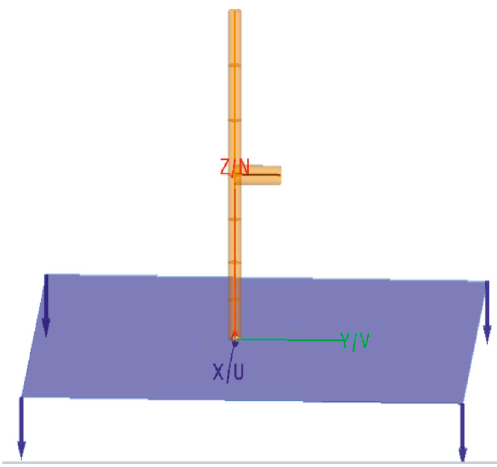
Figure 4: Simulation diagram of the midload whip antenna.